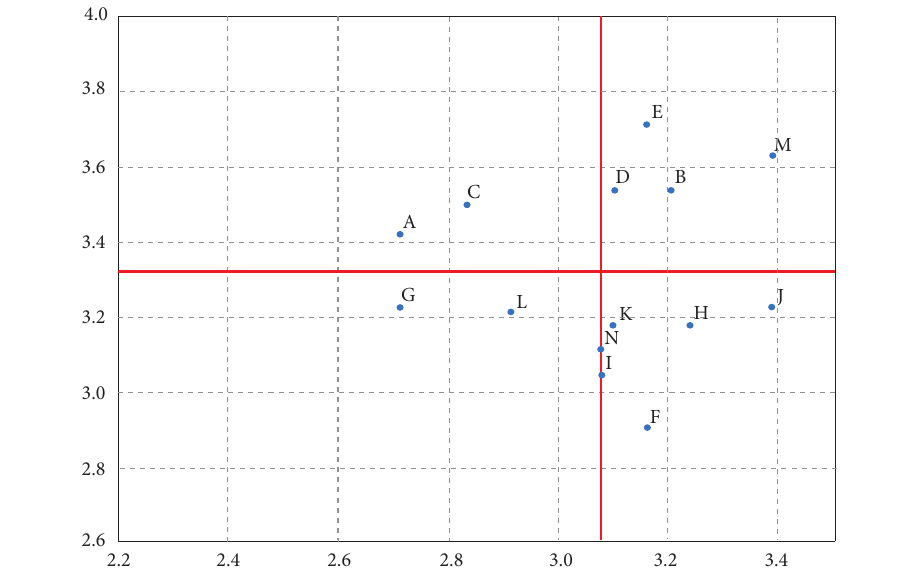
Fig. 16. The scatter diagram of parameters of relations of Ukrainian enterprises with the investor/investor’s